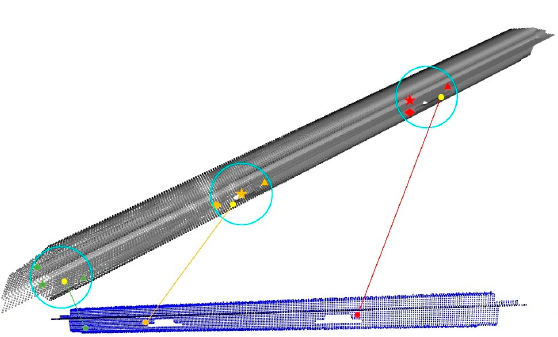
Figure 9. Weighted corresponding points of MD.